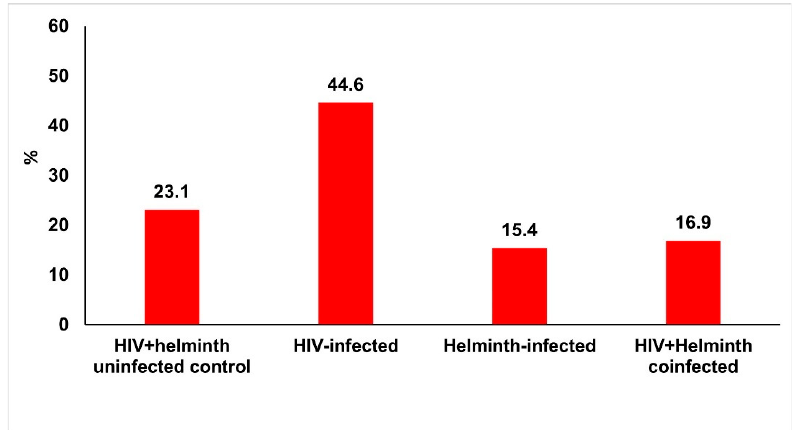
Figure 1. Anaemia prevalence in the study population stratified based on infection status. Anaemia was determined by haemoglobin levels of <12g/dL.